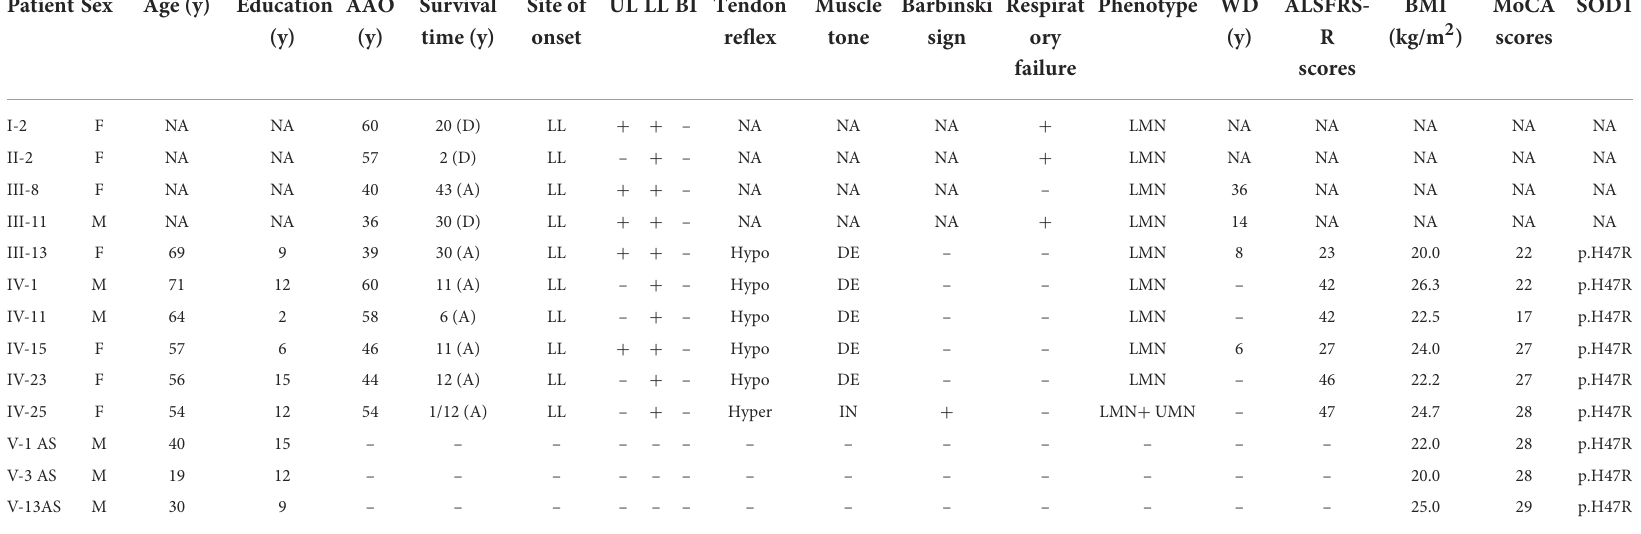
TABLE 1 Clinical and genetic features of 10 patients with ALS and 3 asymptomatic SOD1-H47R carriers. Patient